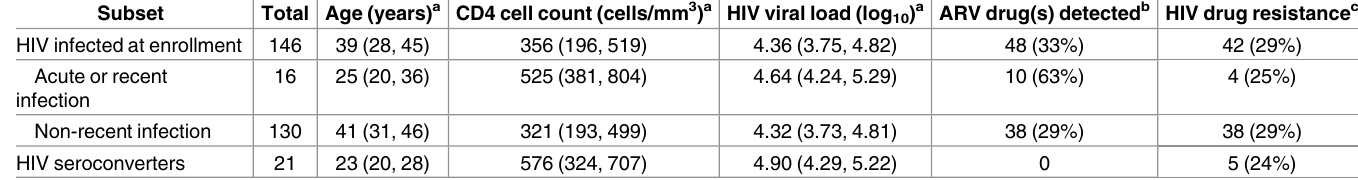
Abbreviations: ARV: antiretroviral. a The median (interquartile range) for age, CD4 cell count, and HIV viral load are shown. b The ARV drug assay was used to detect 15 antiretroviral drugs, including nucleoside/nucleotide reverse transcriptase inhibitors (NRTIs), non-nucleoside reverse transcriptase inhibitors (NNRTIs), and nine protease inhibitors (PIs, see Methods). NRTIs, NNRTIs, and PIs were detected in 30, 8, and 29 HIV- infected men at enrollment, respectively. c Resistance to ARV drugs was assessed using the ViroSeq HIV-1 Genotyping System (see Methods). HIV drug resistance to NRTIs, NNRTIs, and PIs were detected in 20, 35, and 6 HIV-infected men at enrollment, respectively. Four of the seroconverters had HIV resistance to NNRTIs, and one seroconverter had resistance to